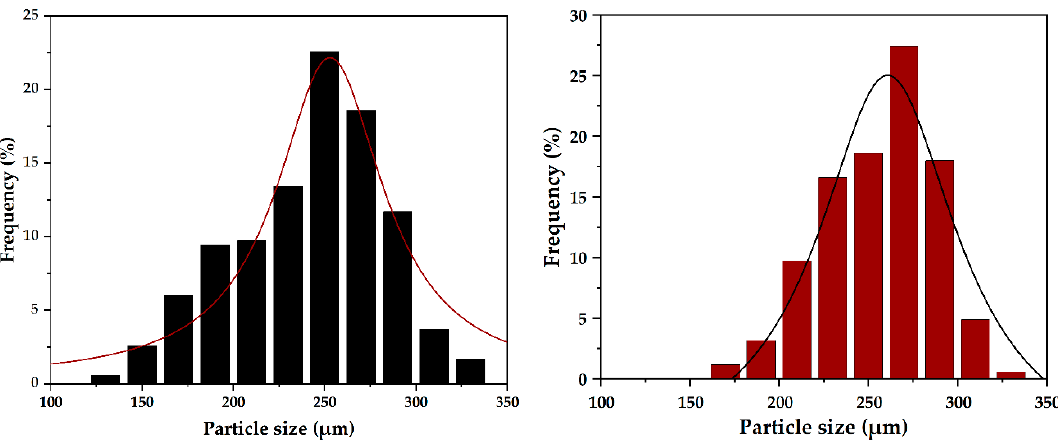
Figure 4. Size distributions and the fitting curves of the two types of magnetite microspheres (8000— left and 20000— right ).